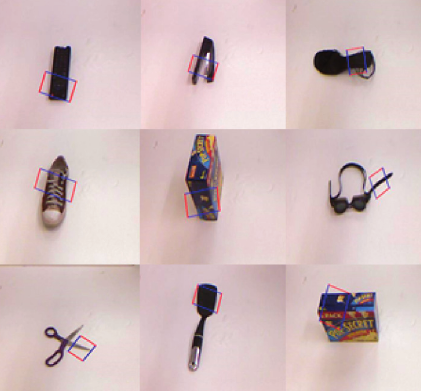
Figure 6: The results of grasp detection on several images of Cornell Grasp